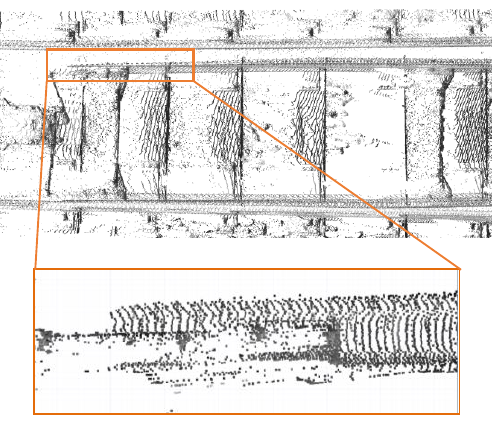
Figure 9. Point blade captured by TLS